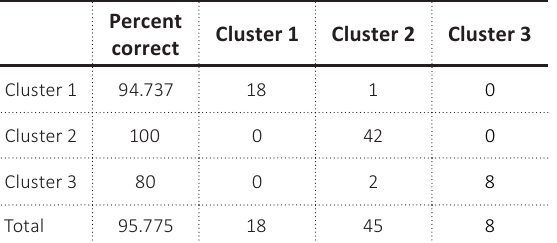
Table 4. Primary clustering results (the primary